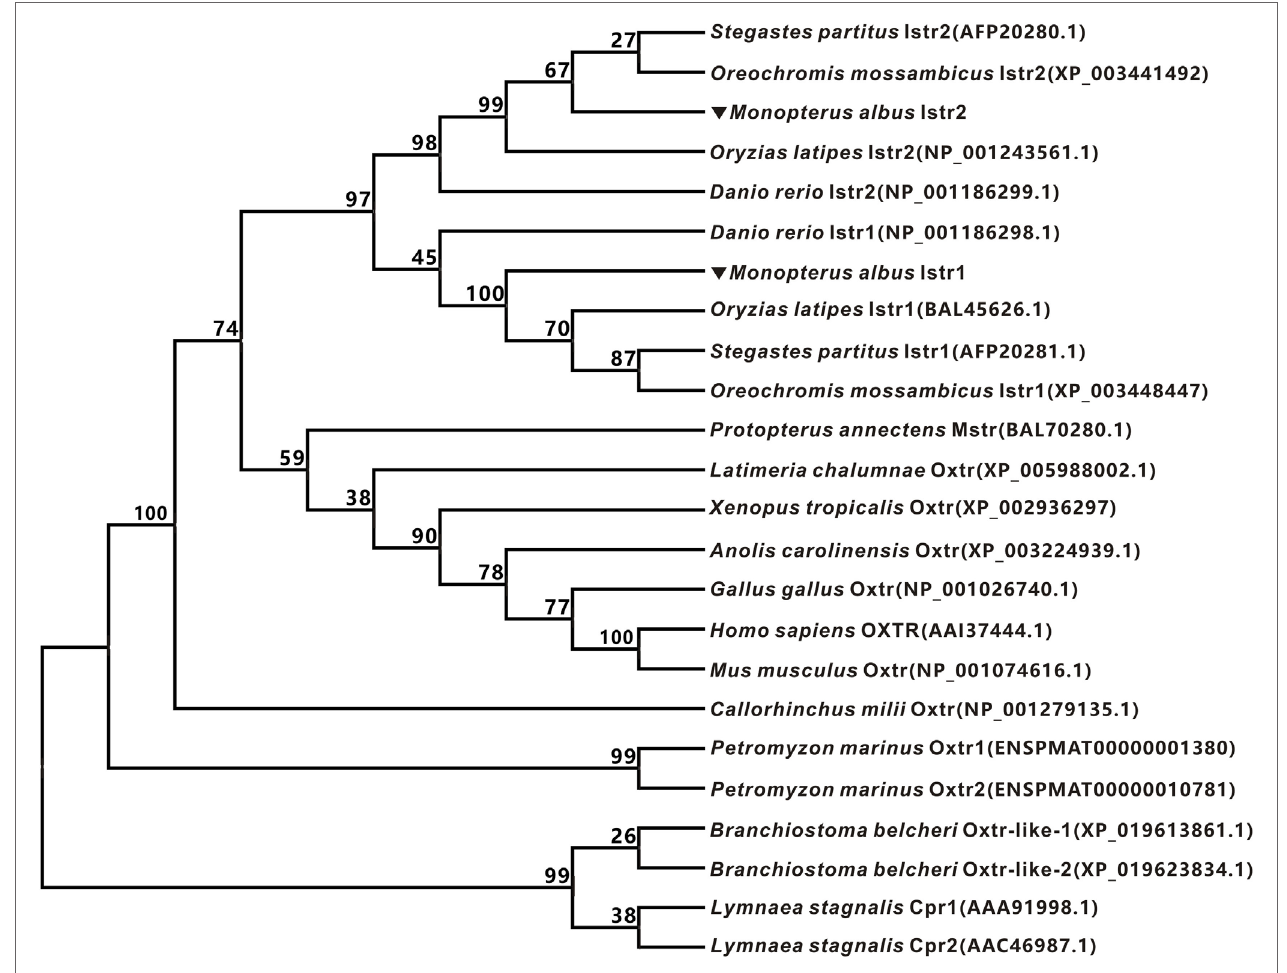
FigUre 1 | Phylogenetic analysis of oxytocin-like receptors of ricefield eel and other vertebrates. The phylogenetic tree was constructed based on an alignment of deduced amino acid sequences by Neighbor-Joining (NJ) method using Mega 7.0 software. The bootstrap values (%, 1,000 replicates) were given at each branch point. The protein sequences were downloaded from Entrez